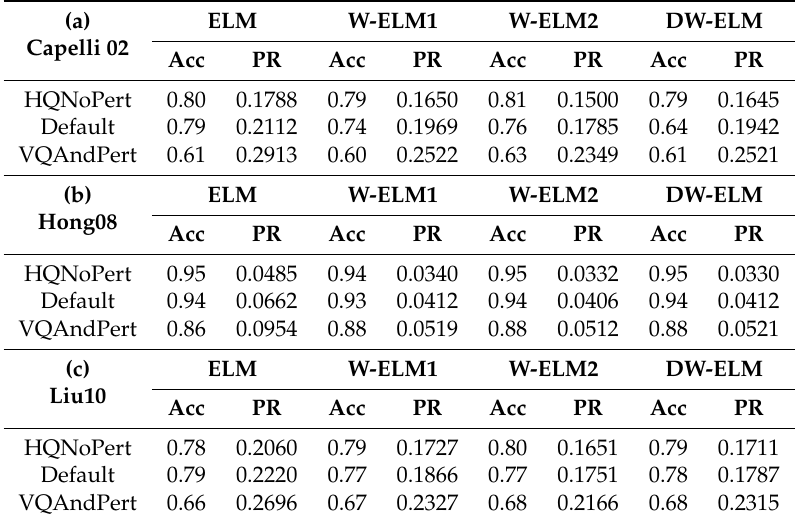
Table 4. Accuracy and absolute-error penetration rates in terms of database and feature extractor by adopting the optimal hyper-parameters of the studied